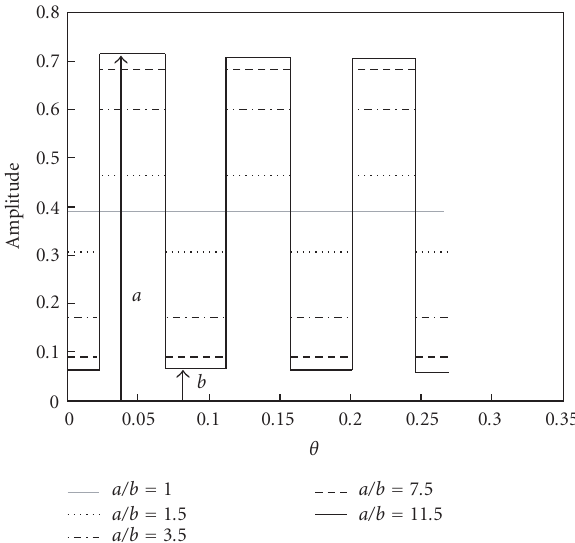
Figure 8: Varied a/b (ratio of the jet-to-wake intensity).